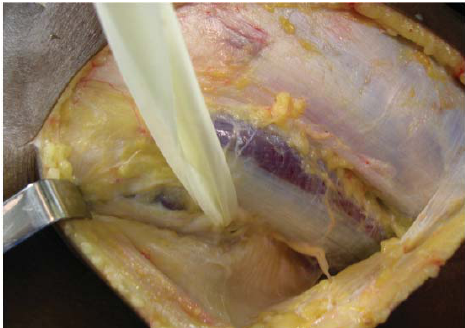
Figure 2 - Exposure of the iliotibial tract and femoral biceps muscle. Note the identification and isolation of the fibular nerve.